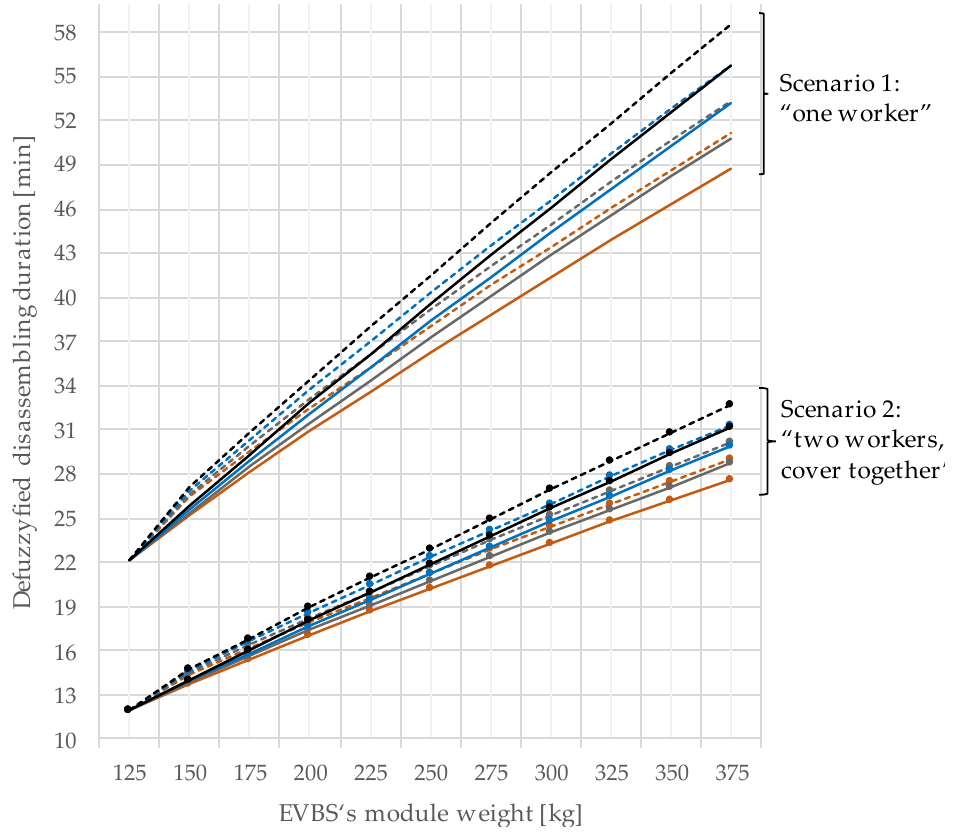
Figure 8. Defuzzyfied disassembling durations depending on EVBS modules’ weight, workforce settings, and scaling parameters for cover removal; line colors represent different beta values for “cover removal” step: brown 0.6, grey: 0.7, blue 0.8, black 0.9; type of line represents gamma: solid: γ = 1; dashed: γ = 1.05.